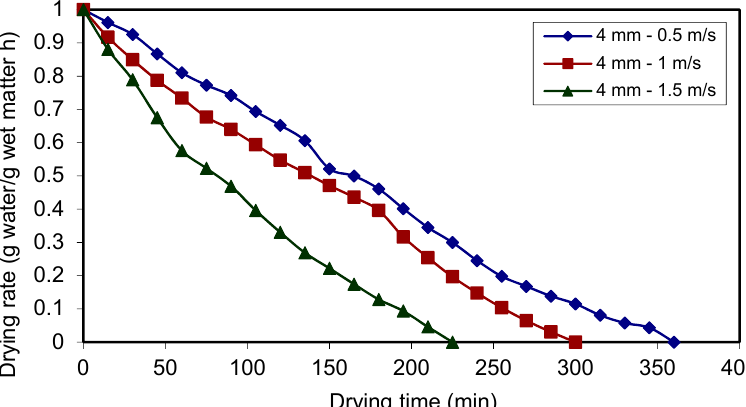
Figure 5. Drying rate as a function of drying time for drying air velocity of 0.5, 1 and 1.5 m/s and slice thicknesses of 4 mm for kiwi fruits.